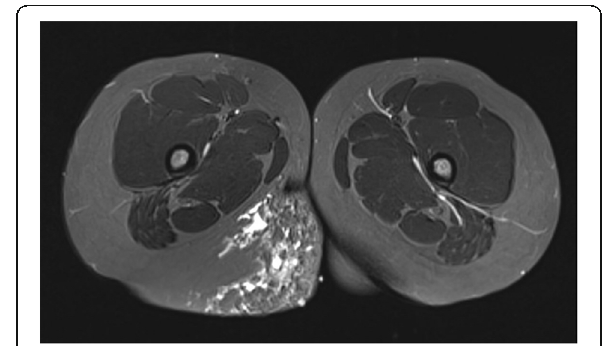
Fig. 9 Axial T2 weighted MR image of a 9 year old male with a lymphatic malformation of the right buttock. The subcutaneous lymphatic cysts, which are of high T2 signal, are of varying sizes and there is additional fat present, contributing to the bulk of the lesion